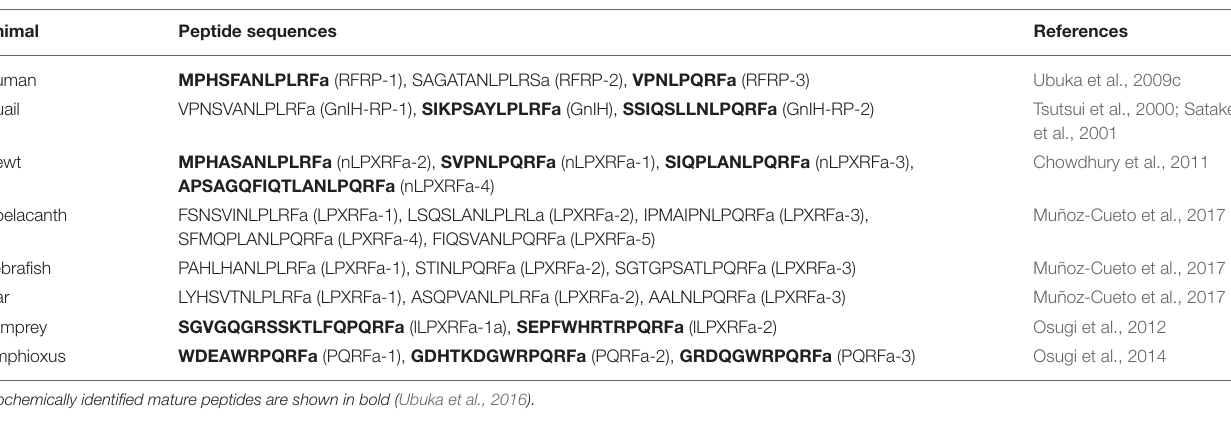
TABLE 1 | Representative GnIH (LPXRFa) peptides of chordates.